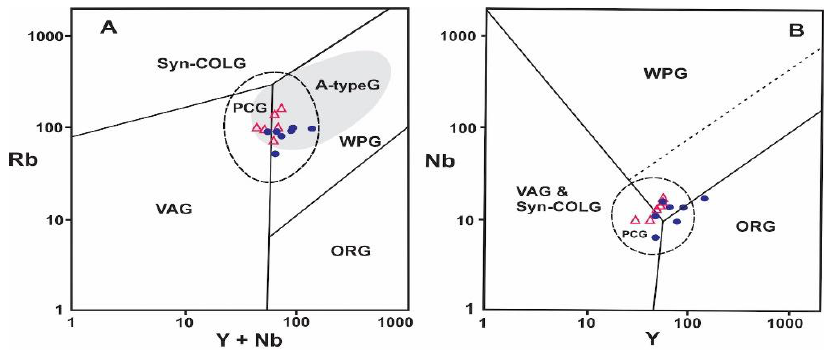
Figure 8. Plot of the Wadhrai granite analyses on Rb vs. Y+Nb ( A ) and Nb vs. Y ( B ) diagrams after